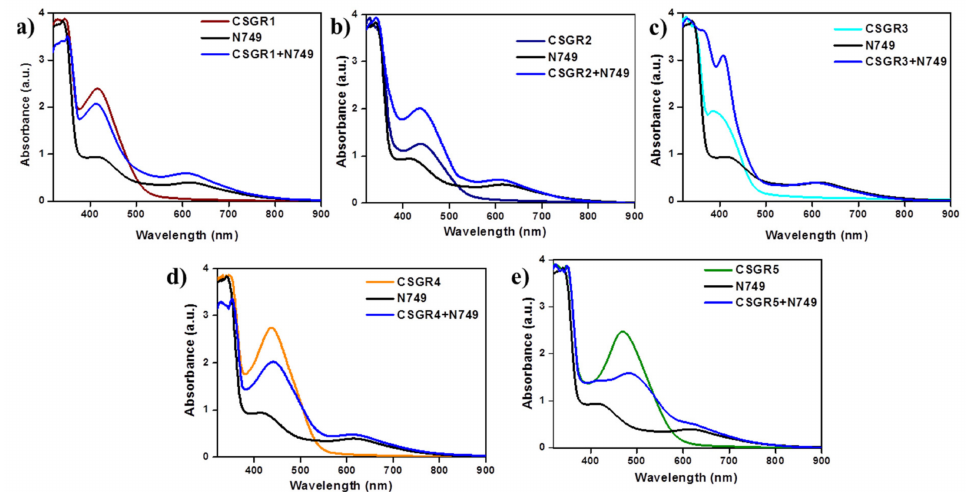
Figure 5. ( a–e ) are comparative absorption spectra of CSGR (0.3 mm), N749 (0.3 mm) and mixture of N749 and CSGR dyes (0.2 and 0.1 mm) on TiO 2